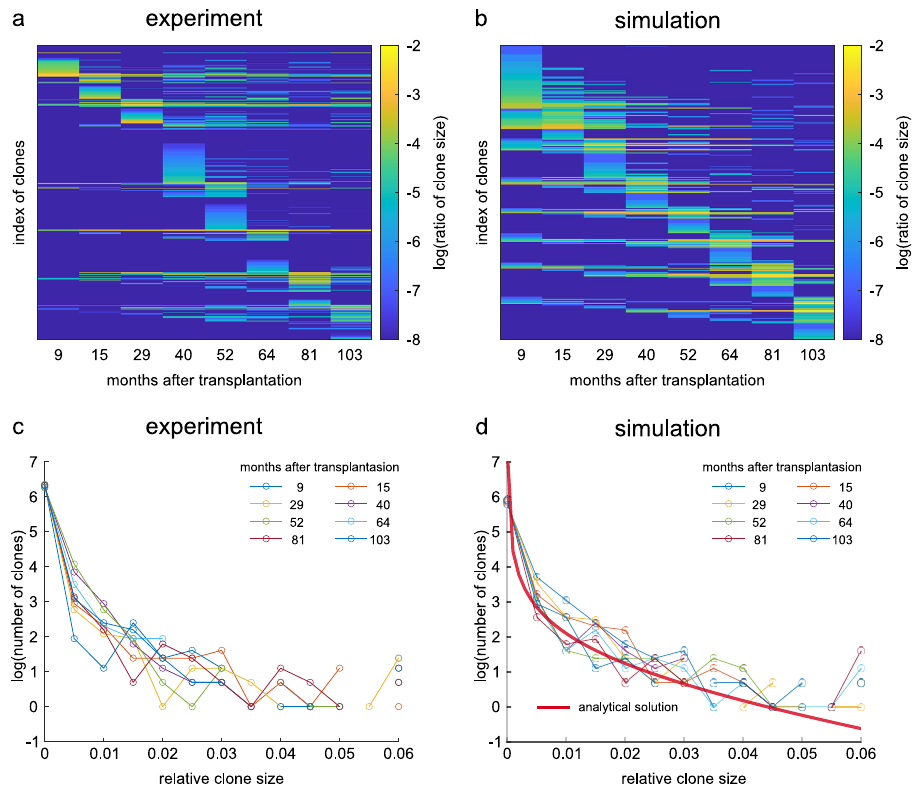
Fig. 5 Comparison of clonal expansions between experiments and simulations of the hNC model in primate hematopoiesis. a Decade-long time-series of clone sizes of stem cells in primate hematopoiesis. The data are publicly available from Kim et al., Cell Stem Cell (2014) 20 . Clones were sorted by time points of maximum population size. b Time-series of clone sizes in the simulation of the hNC model. Parameters were K = 420, N = 1000, and ε = 0.05. ε was estimated from the data in ( a ) (see Methods). One month corresponds to 1000 steps in the simulation. c , d Histogram of clone size at different timepoints in the experiment ( c ) and simulation ( d ). Red line in ( d ) indicates the analytical solution of stationary distribution of clone